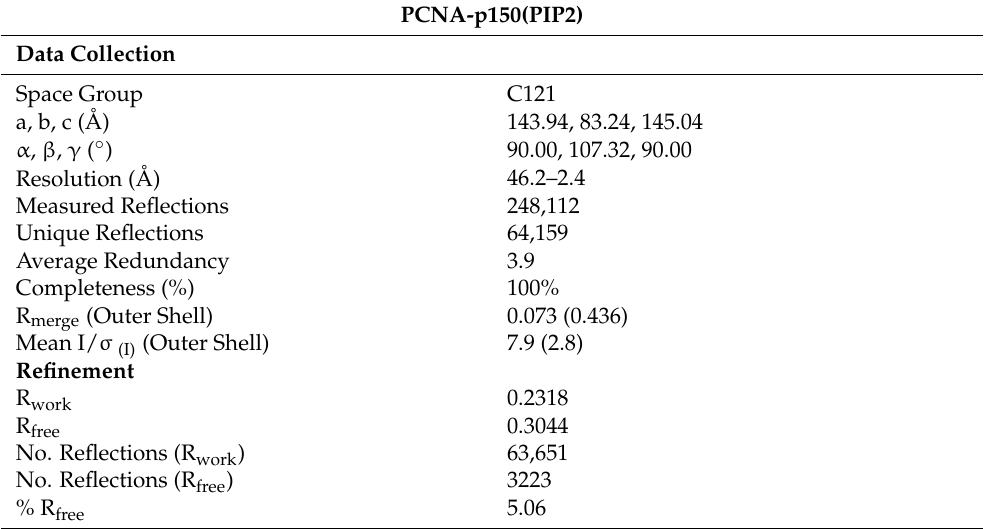
Table 1. Summary of crystallographic